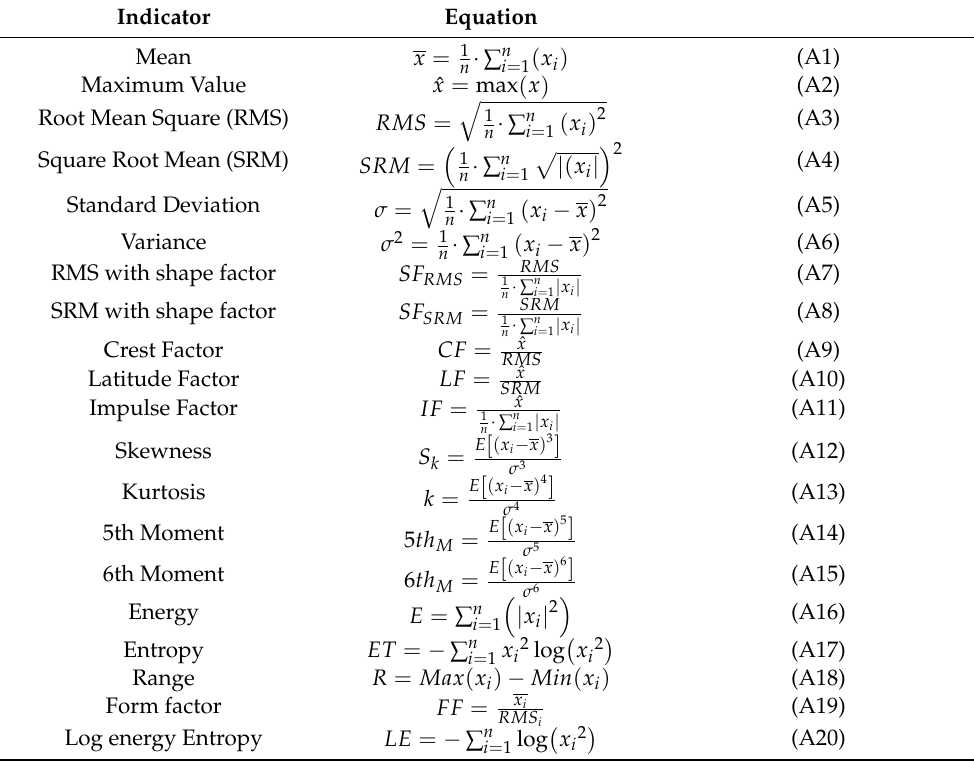
Table A1. Statistical and non-statistical